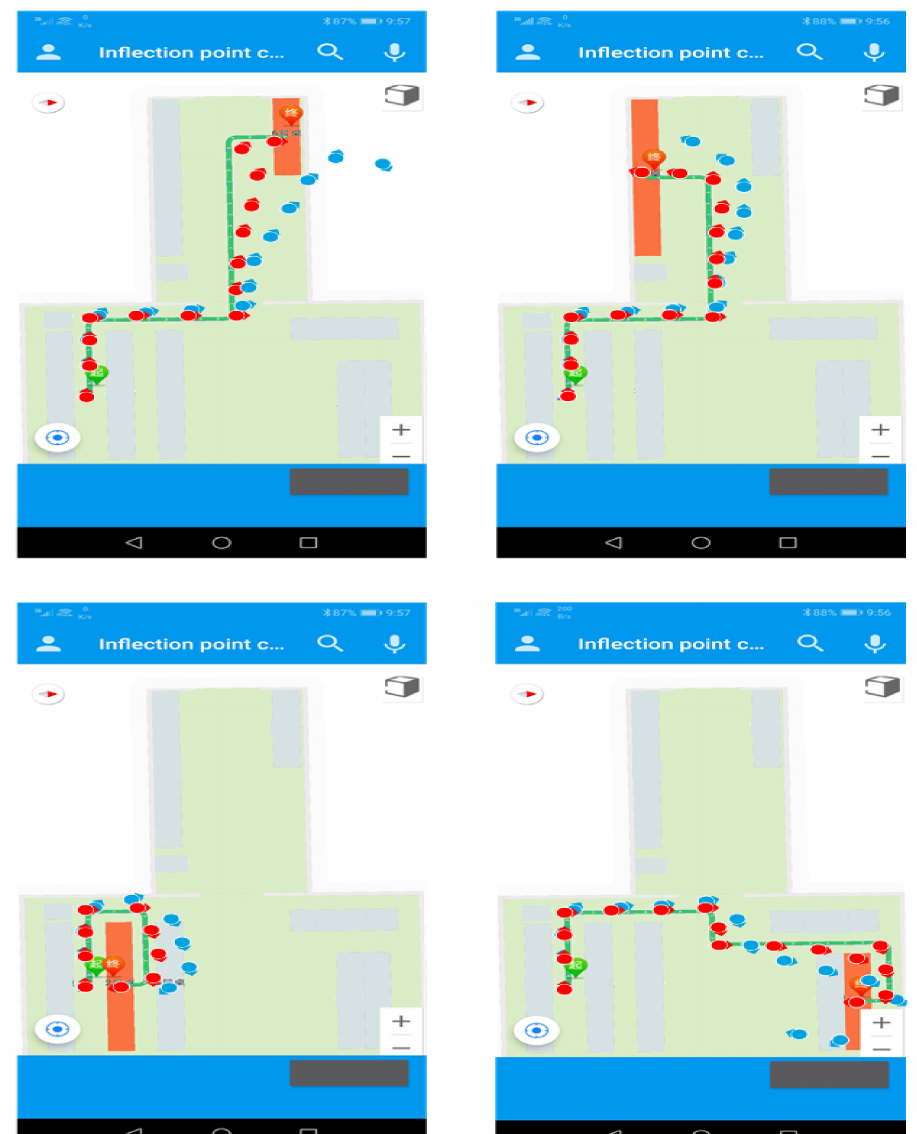
Figure 12. Positioning test results in a small-scale indoor environment.